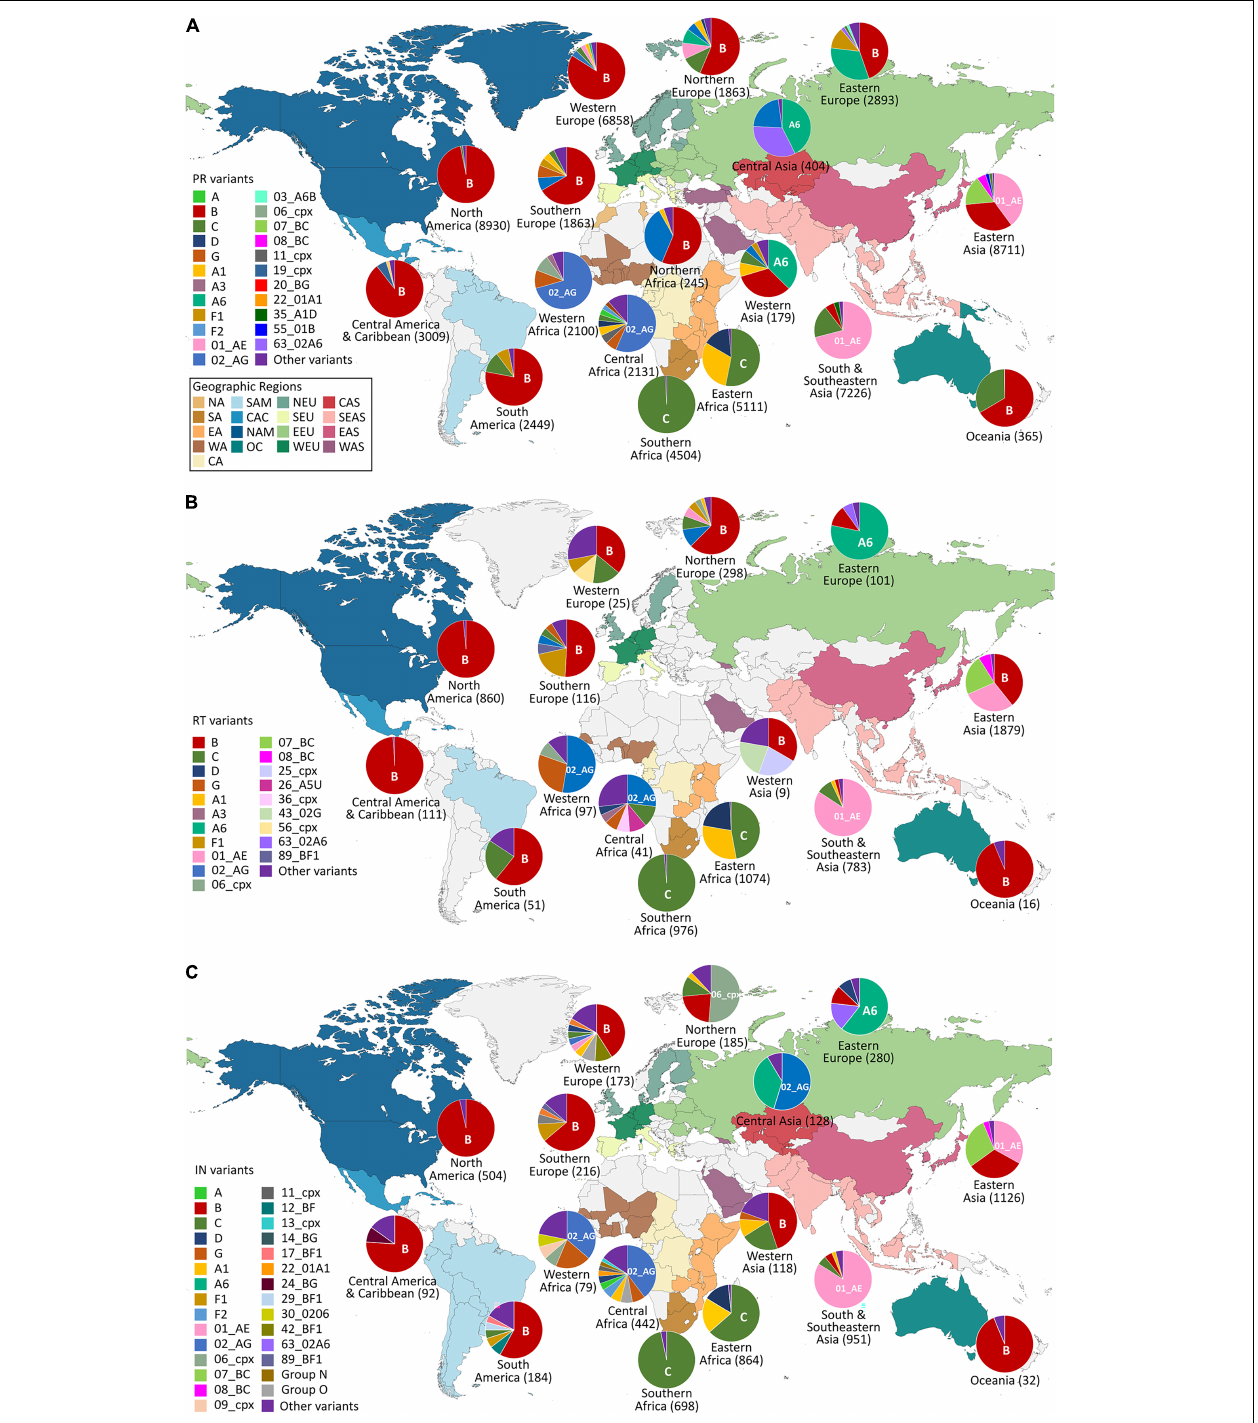
FIGURE 2 | Geographic distribution by regions of HIV-1 Pol variants available in Los Alamos HIV sequence database (LANL) in January 2022. HIV-1 variant distribution within regions in PR (A) , RT (B) , and IN (C) . PR, Protease; RT, reverse transcriptase; IN, integrase. Countries are colored by regions according to the United Nations geoscheme (https://unstats.un.org). Geographic regions color code inside the box in (A) . Pie graphs show the percentage of the HIV-1 variants per region as available in LANL in January 2022 and the most frequent variant per region. The total number of available LANL sequences per region is in brackets beside the region name. NA, Northern Africa; SA, Southern Africa; EA, Eastern Africa; WA, Western Africa; CA, Central Africa; SAM, South America; CAC, Central America and The Caribbean; NAM, North America; OC, Oceania; NEU, Northern Europe; SEU, Southern Europe; EEU, Eastern Europe; WEU, Western Europe; CAS, Central Asia; SEAS, Southern and Southeastern Asia; EAS, Eastern Asia; WAS, Western Asia.